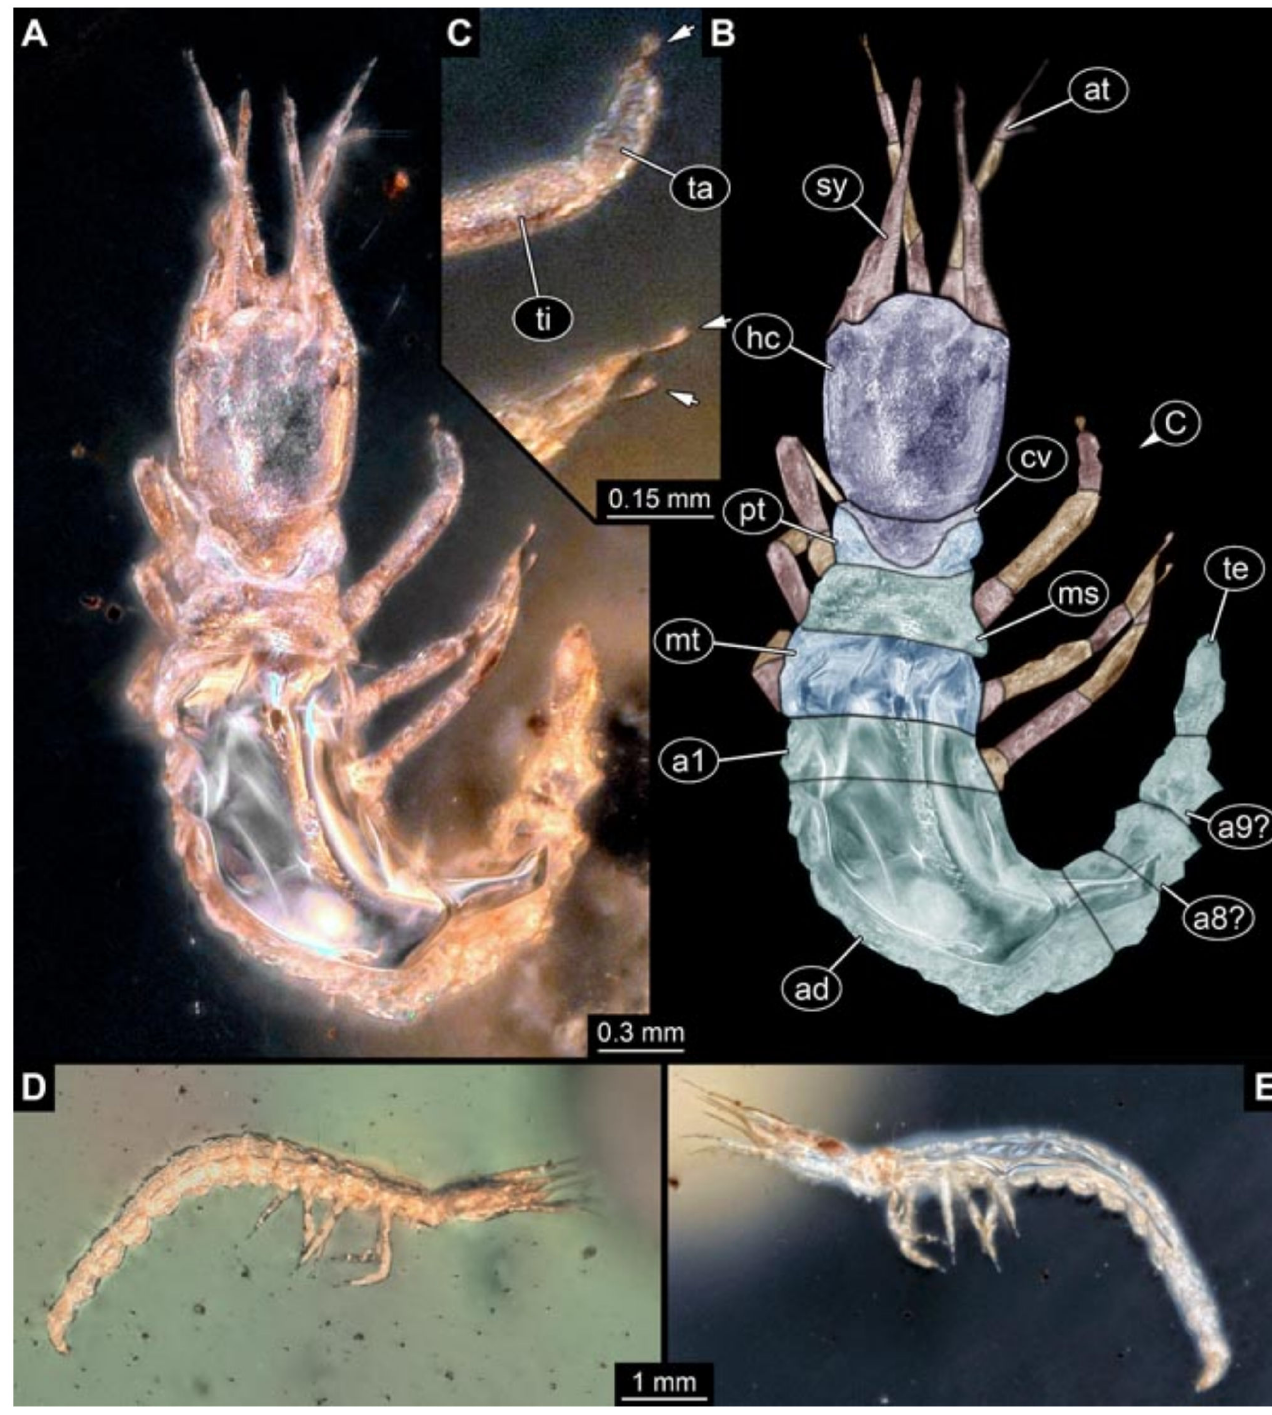
Figure 4. Specimens in Myanmar amber ( A – C ) Specimen 5823 (BUB 3064-1). ( A ) Dorsal view. ( B ) Dorsal view, colour marked. ( C ) Close-up of trunk appendage with empodium (arrows). ( D – E ) Specimen 5824 (BUB 3064-2). ( D ) Lateral view, slightly dorsally. ( E ) Lateral view, slightly ventrally. Abbreviations: a1 = abdomen segment 1; a8?–a9? = possible abdomen segments 8–9; ad = abdomen; at = antenna; cv = cervix; hc = head capsule; ms = mesothorax; mt = metathorax; pt = prothorax; sy = stylet; ta = tarsus; te = trunk end; ti =